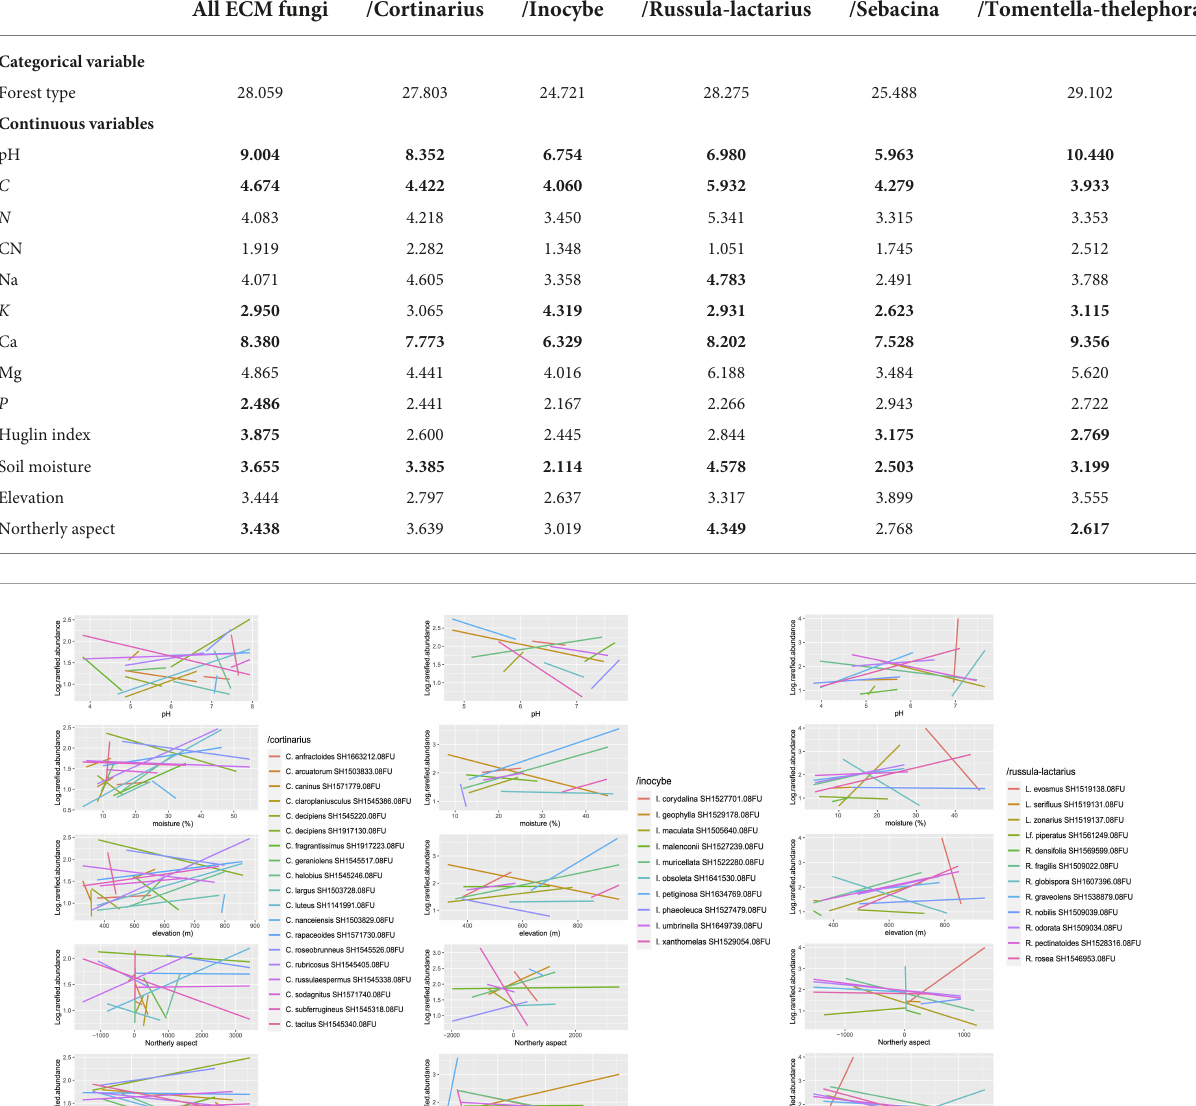
TABLE 2 Proportions (%) of compositional variance explained by environmental variables in individual models based PERMANOVA, with variables providing significant, unique contribution to the combined model indicated in bold.